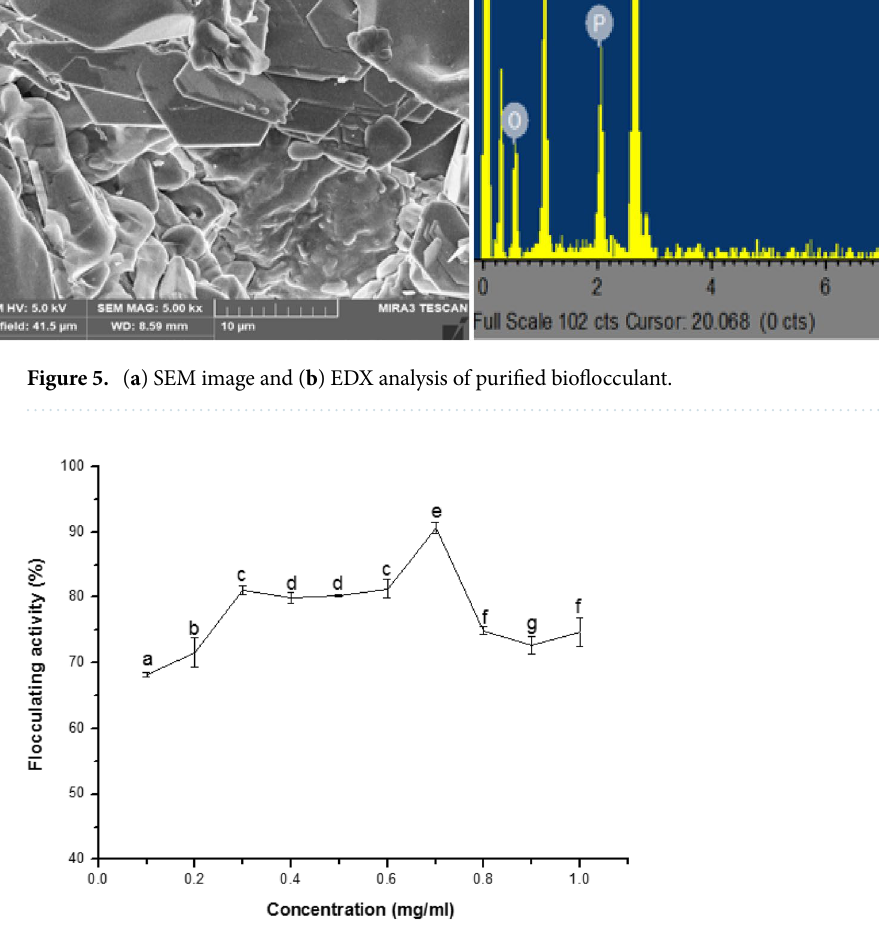
Figure 6. The effect of concentration on the treatment of brewery wastewater. The percentage of flocculating activities of different alphabetic letters differs significantly (p < 0.05).